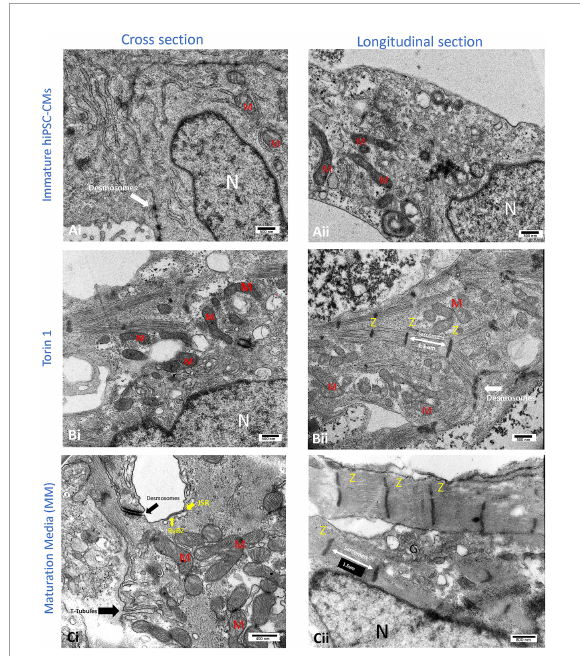
FIGURE3 Transmission electron microscopy (TEM) images of the cellular structure of human-induced pluripotent stem cell-derived cardiomyocytes (hiPSC-CMs) after 14 days of 200 nM Torin1 (mTORC1/C2 inhibitor) exposure (B) or 4–5 weeks of metabolic maturation media (MM) (C) . In comparison to untreated hiPSC-CMs (A) , cells treated with Torin 1 and MM media show dramatically enhanced ultrastructure. In cells treated with Torin 1, prominent Z-lines with aligned and elongated sarcomeres ( ∼ 1.3 µ m) are observed (Bii) . In addition to desmosomes, golgi, and endoplasmic reticulum, the formation of interspersed mitochondria is also observed (Bi) . In cells incubated with MM media for four to five weeks, packed mitochondria with well-formed cristae, more significant junctional SR, with possible T-tubule formation are also observed (Ci) . In addition to dense peri-nuclear mitochondria, surface dyads with RyR2 on junctional SR were observed (Ci) . JSR, junctional SR. M, mitochondrion. N, nucleus. RyR2, type II ryanodine receptor. Z, Z line. i, cross sections of the hiPSC-CM. ii, longitudinal section of the